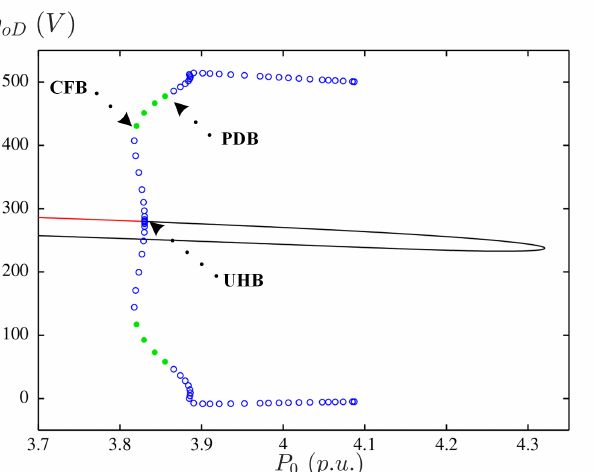
Figure 13. Bifurcation diagrams for the ZIP and ZIP+IM models.